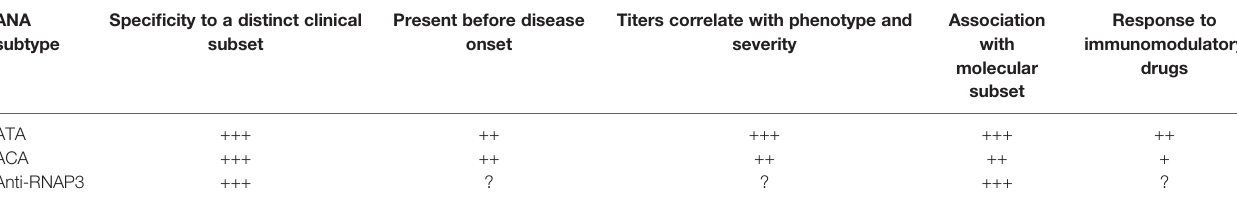
TABLE 1 | Clues of ANA pathogenicity in